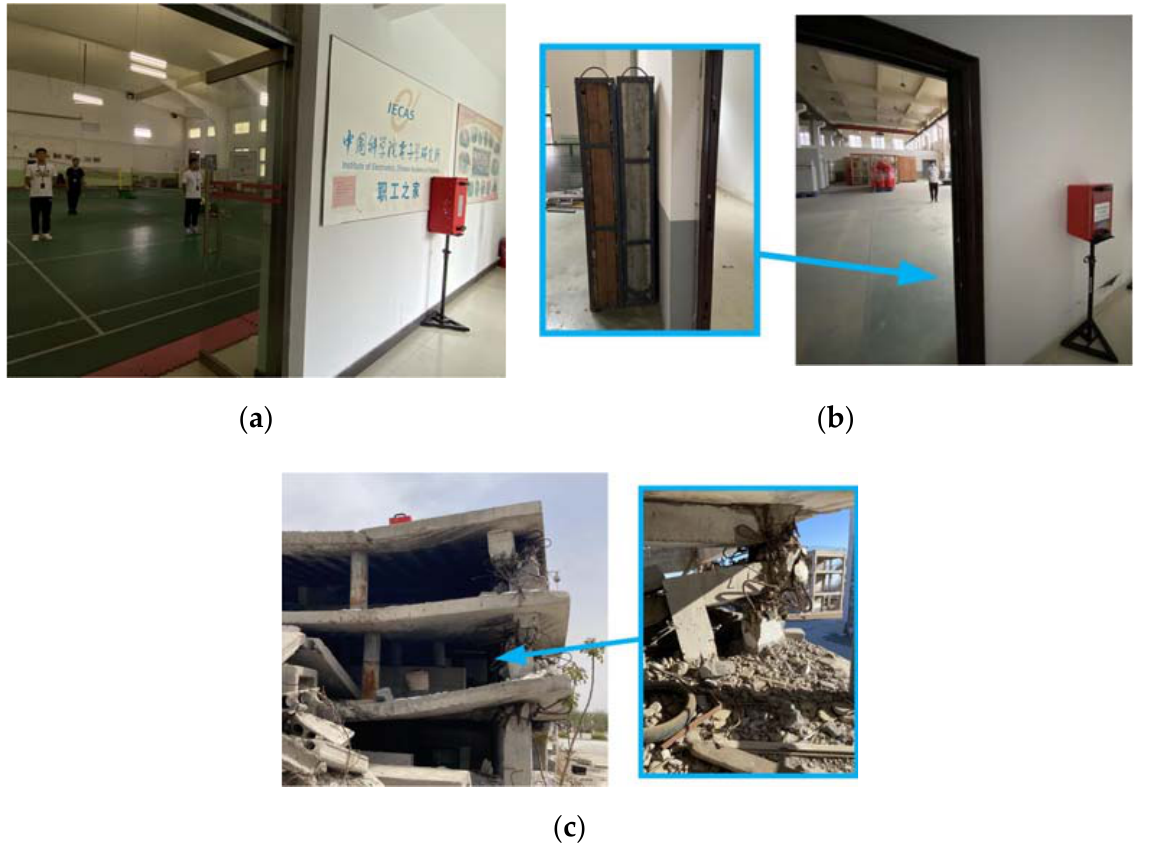
Figure 4. The scenarios for dataset collection: ( a ) Scenario 1: the standard brick wall; ( b ) Scenario 2: the multi ‐ layer medium; ( c ) Scenario 3: the actual ruin.